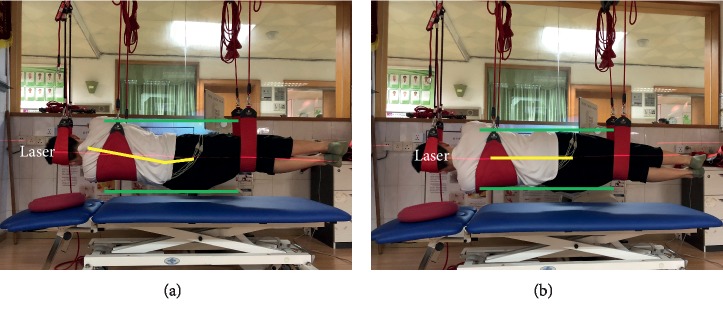
LSLS/RSLS performed.